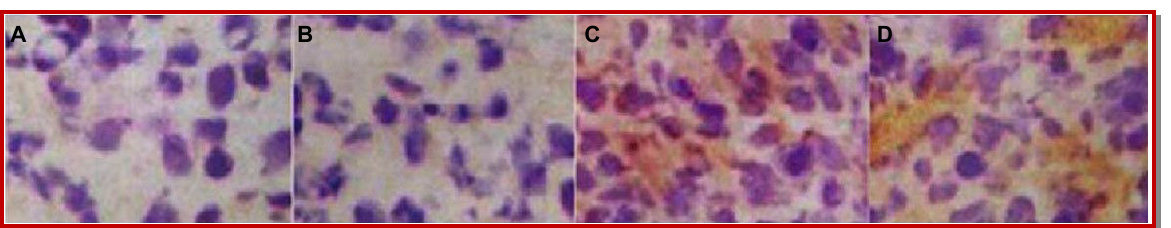
Figure 1: MRI results of intracranial tumors in situ. (A) control group; (B) low-dose group; (C) medium-dose group; (D) high-dose group